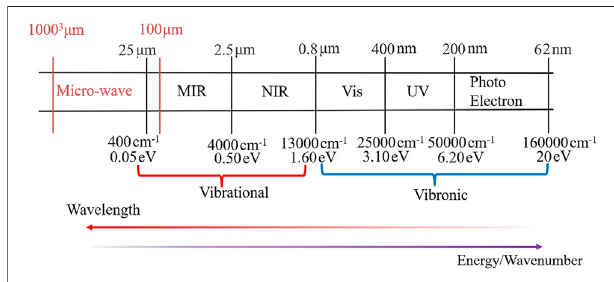
FIGURE 1 | The wavelength and energy range corresponding to vibrational and vibronic spectra